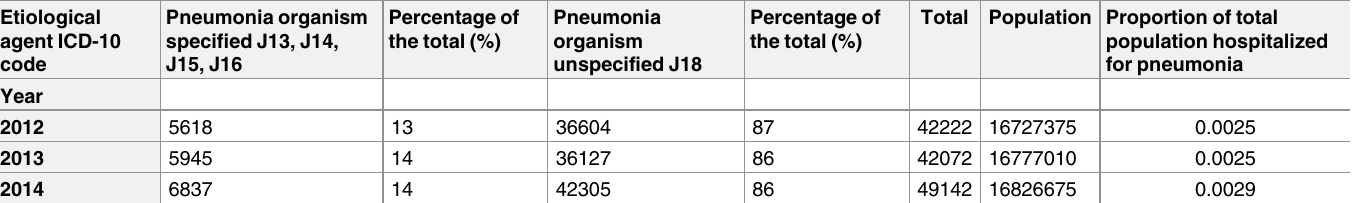
Table 1. Counts of hospital admissions for pneumonia in 2012, 2013 and 2014 for different ICD-10 discharge codes. In the majority of cases the etio- logicalagent is not determined and the ICD dischargediagnosisis ‘pneumonia organism unspecified’. The proportionof pneumonia cases in 2014 is signifi- cantly higherthan in 2012 and in 2013 (One sided Pearson’s Chi squarestatistics, p-value < 0.001). Etiological Pneumonia organism specified J13, agent ICD-10 code